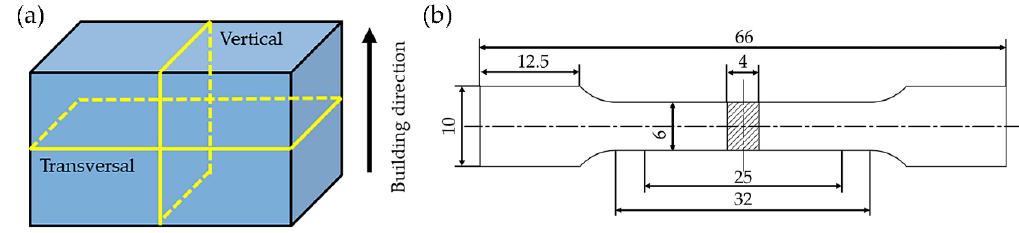
Figure 5. ( a ) Illustration diagram of sample direction; ( b ) dimensions of tensile sample.